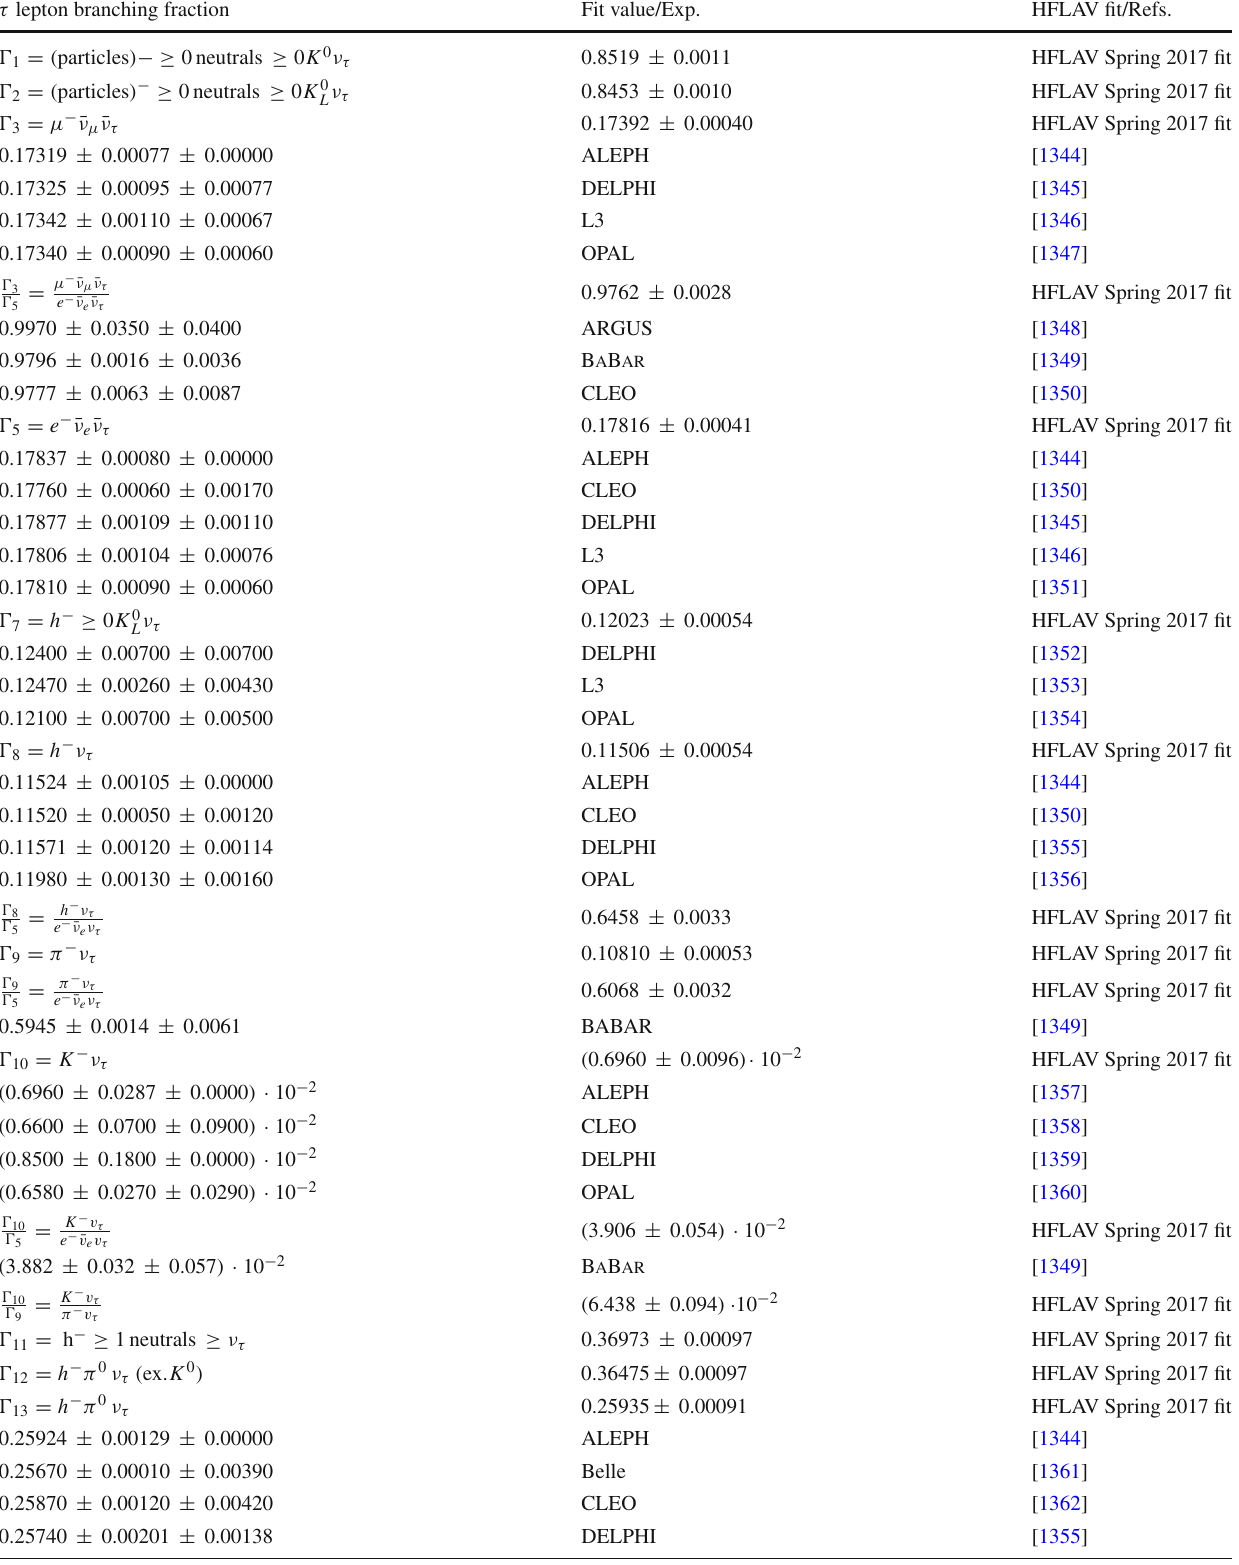
Table 304 HFLAV Spring 2017 branching fractions fit results τ lepton branching fraction Fit value/Exp. HFLAV